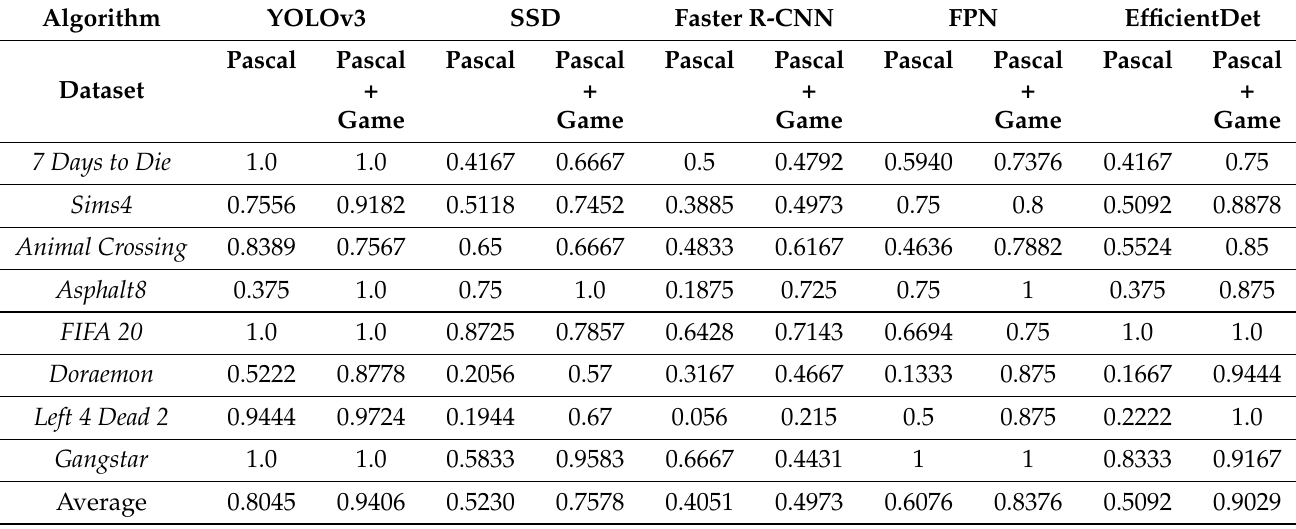
Table 2. The comparison of mAPs for each game. We compared five object detection algorithms pre-trained by PascalVOC and retrained by PascalVOC with game scenes. Note that PascalVOC is abbreviated as Pascal in the table. Algorithm